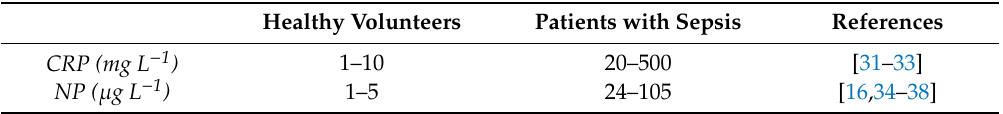
Table 2. Clinical range of interest for CRP and